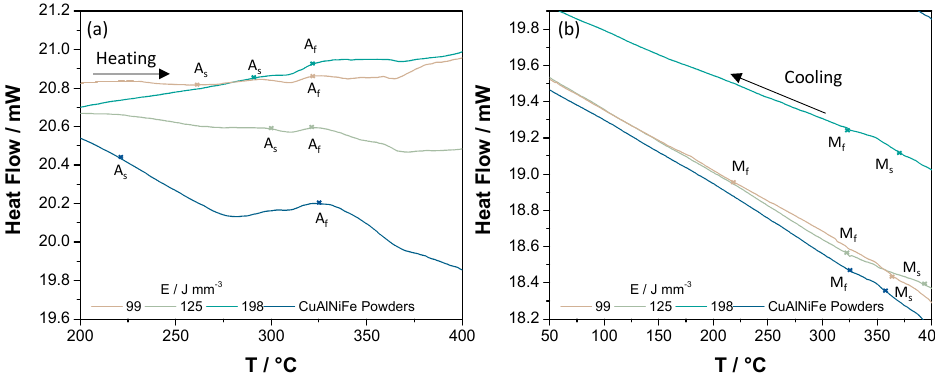
Figure 9. DSC results of alloy powder and as-built samples under ( a ) heating and ( b ) cooling in a nitrogen atmosphere at 20 mL ∙ min − 1 .